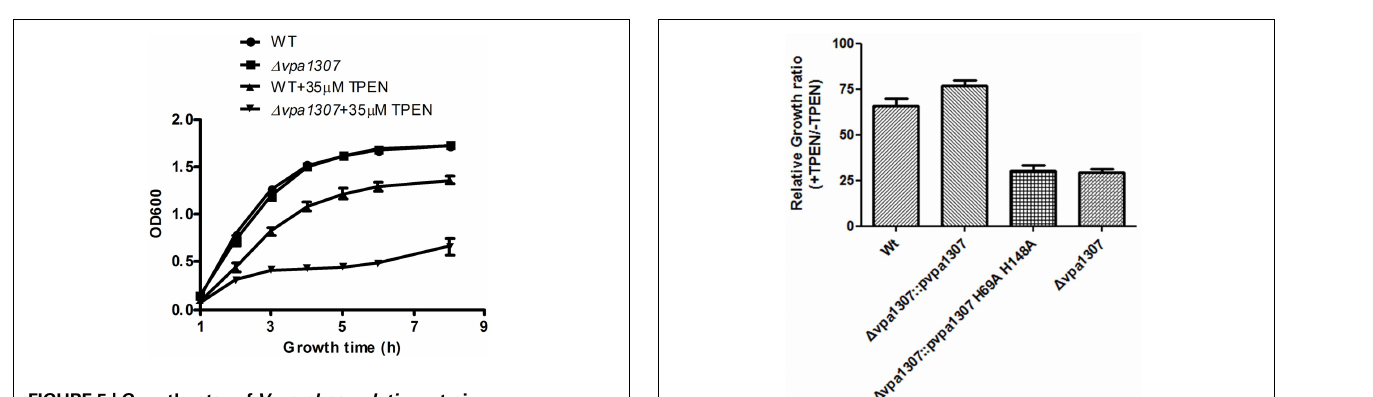
FIGURE 5 | Growth rates of V. parahaemolyticus strains. V. parahaemolyticus strains were cultured in LB or LB supplemented with